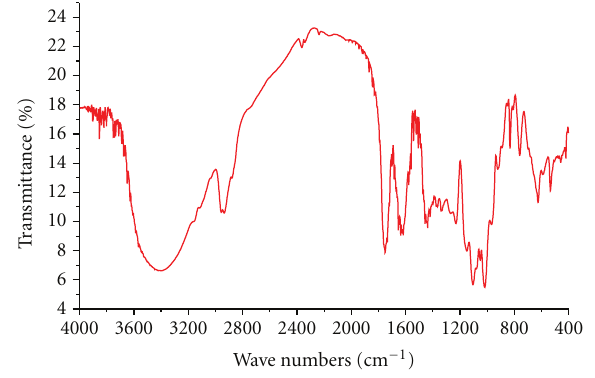
Figure 7: FT-IR spectrum of pectin obtained by the MAE method with ionic